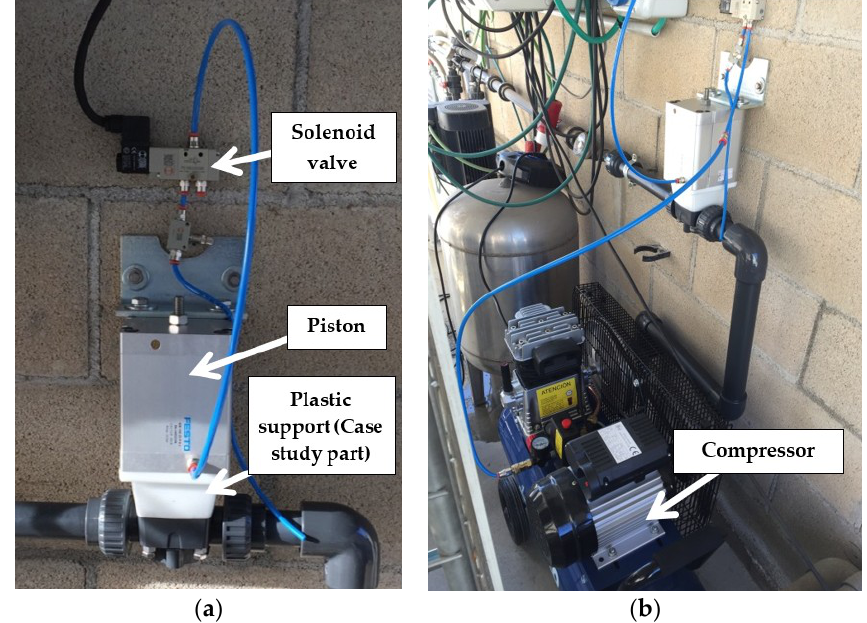
Figure 15. Physical testing of the printed part. It can be seen how the command circuit is mounted on a main fluid circuit. ( a ) Detailed view of the support mounted under the pneumatic piston. On top, the solenoid valve. ( b ) General overview of the fluid testing set, containing the compressor, valves, piston and the case study support.